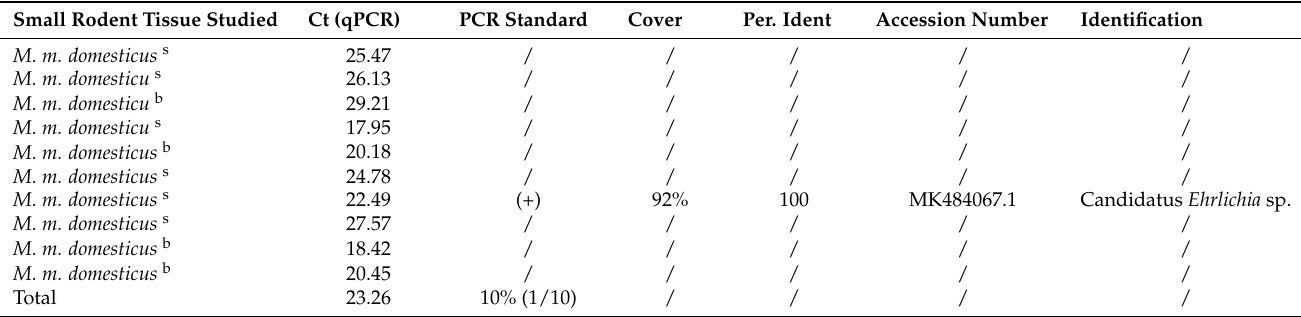
b = brain tissue; s = spleen